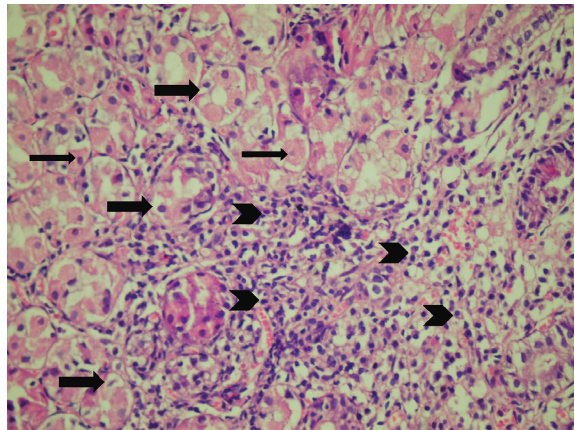
Figure 2: Photomicrograph showing chronic superficial gastritis with mixed inflammatory cell infiltrate (arrow heads), mainly lymphocytes and plasma cells; some glandular epithelial cell shows reactive changes, for example, subnuclear vacuolization (arrows) and parietal cell hyperplasia (thin arrow), H&E, × 200.